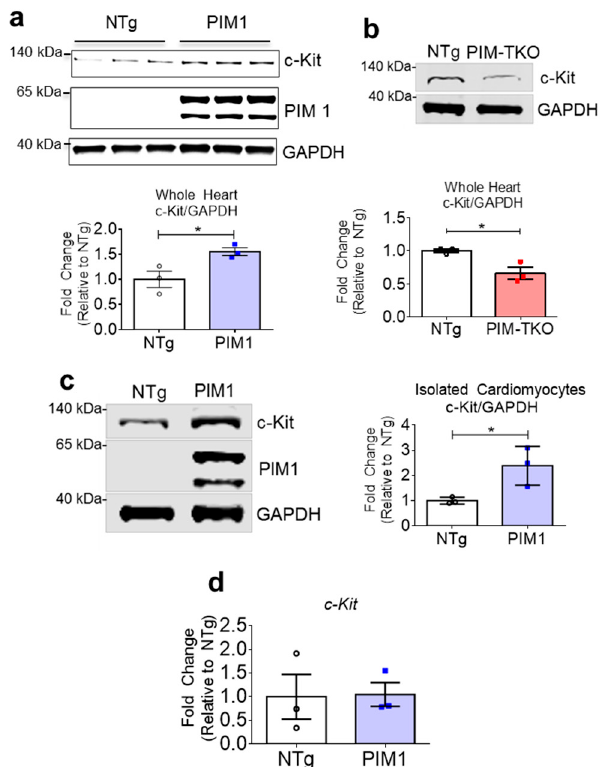
Figure 1. PIM1 upregulates c-Kit protein expression. ( a ) Immunoblot analysis showing expression of c-Kit in PIM1 vs. NTg whole heart lysates with quantification below. N = 3, Error bars represent SEM, * p < 0.05 vs. untreated as measured by Student t test. ( b ) Immunoblot analysis showing the expression of c-Kit in PIM-TKO vs. NTg whole heart lysates with quantification shown below. N = 3, error bars represent SEM, * p < 0.05 vs. untreated as measured by Student t test. ( c ) Immunoblot analysis showing c-Kit expression in cardiomyocytes isolated from PIM1-overexpressing hearts vs. NTg with quantification on the right. N = 3, error bars represent SEM, * p < 0.05 vs. untreated as measured by Student t test. ( d ) Gene expression of c-Kit in cardiomyocytes isolated from PIM1 and NTg hearts as revealed by qPCR. N = 3, Error bars represent SEM.